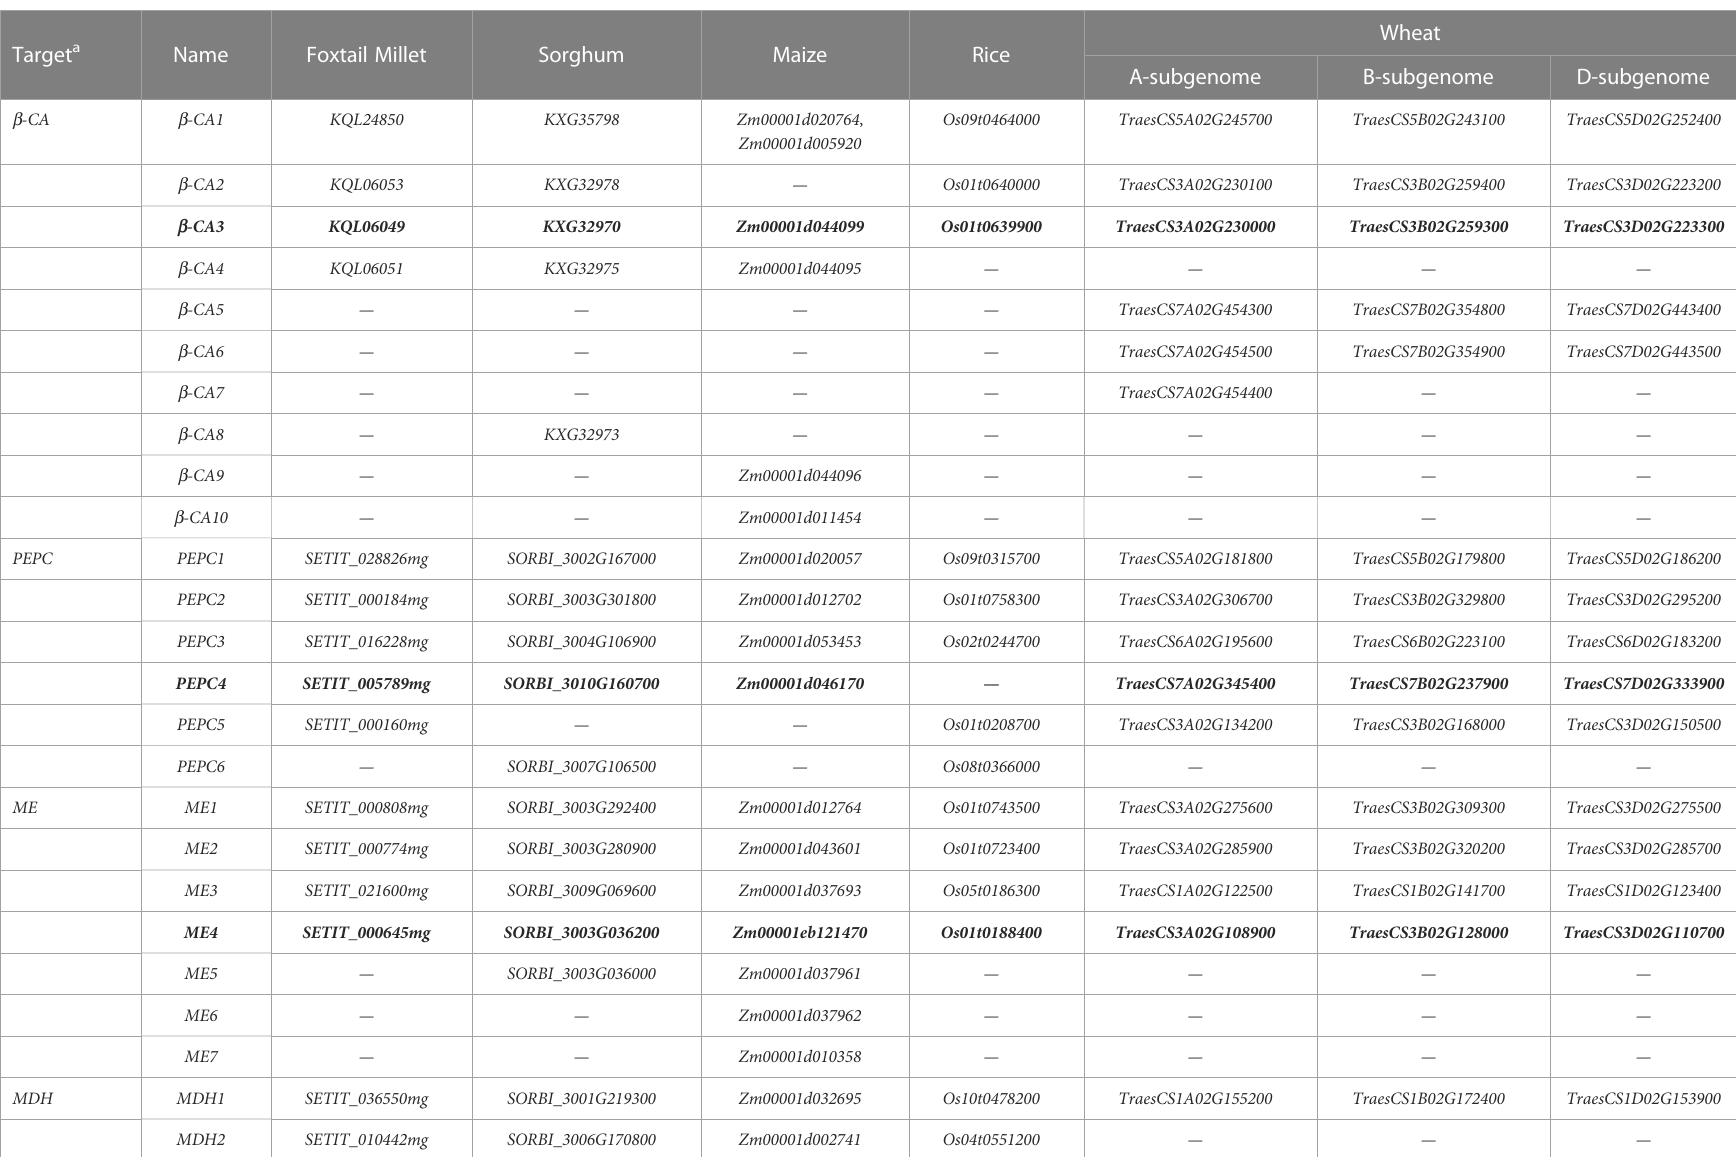
TABLE 2 b -CA , PEPC , ME , and MDH genes involved in the C 4 photosynthesis pathway in fi ve gramineous